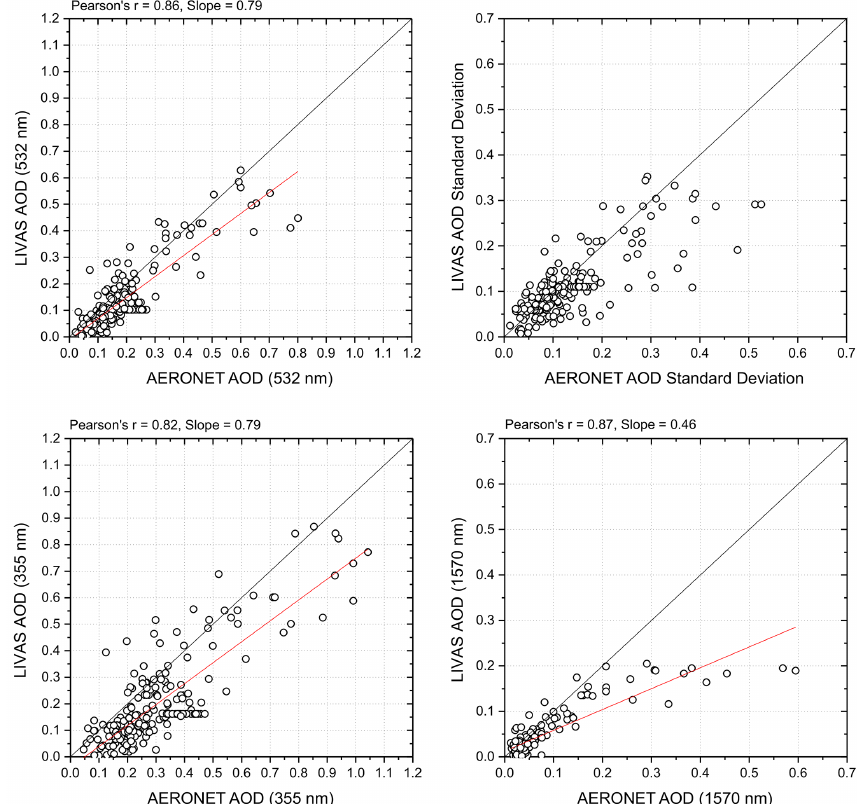
Figure 16. Upper panel: scatter plot comparisons of LIVAS AODs at 532nm versus collocated AERONET Level 2 product (left) and of standard deviation of the LIVAS AODs versus standard deviation of the AERONET AODs at 532nm (right). Lower panel: scatter plot com- parisons of LIVAS AODs at 355nm versus collocated AERONET Level 2 product (left) and of LIVAS AODs at 1570nm versus collocated AERONET Level 2 product